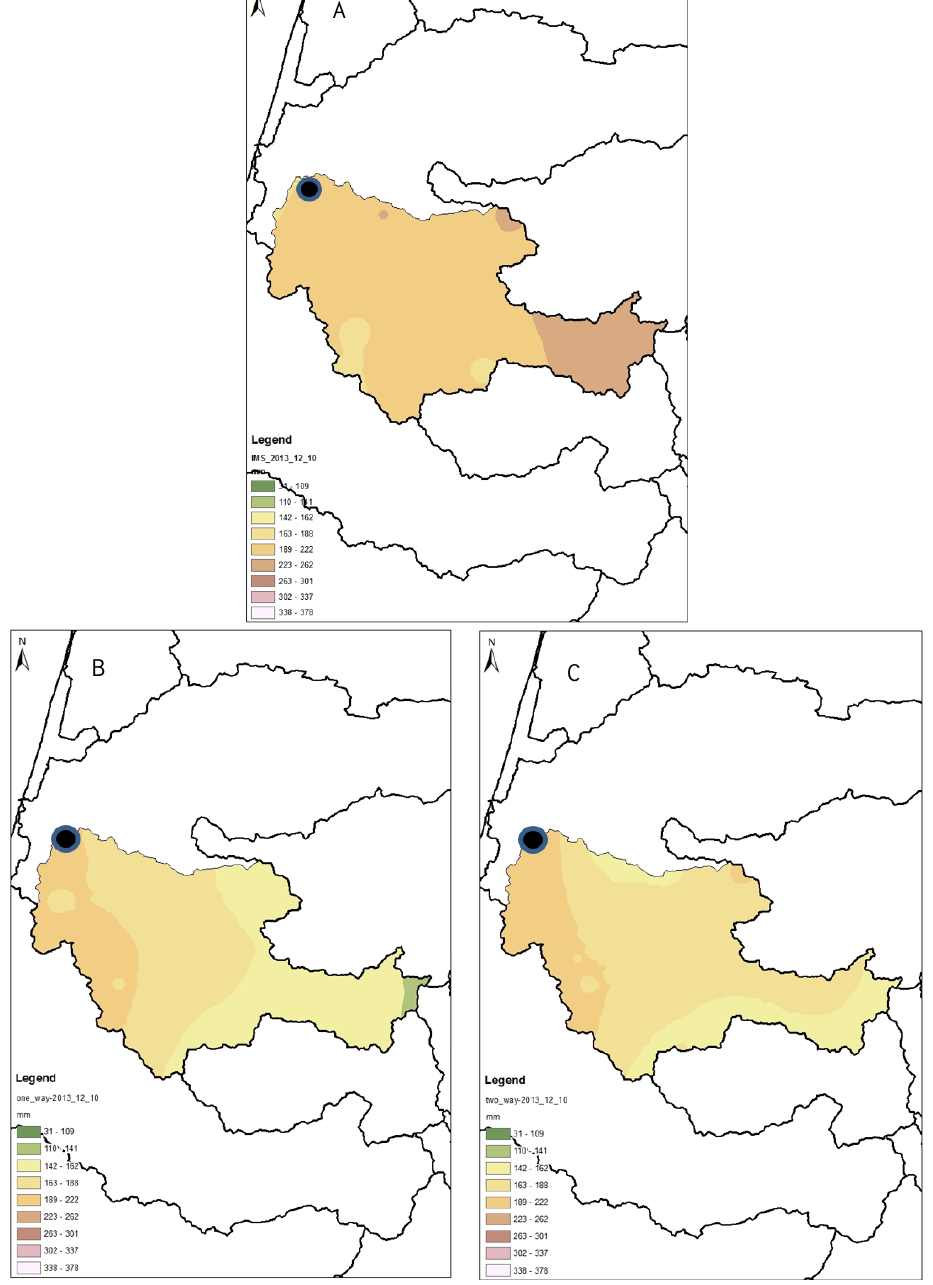
Figure 7. Figure 6A–C: Accumulated observed precipitation at the Ayalon basin for the December storm ( A ); WRF one way ( B ) and WRF two way ( C ) simulated precipitation (the black dot in the figure is the Ayalon-Ezra hydrometric station at the outlet of the basin).